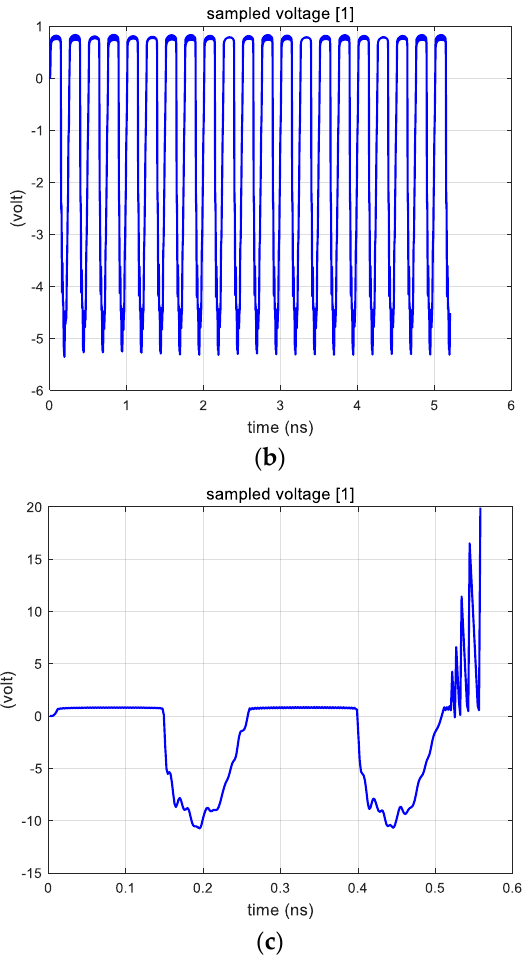
Figure 11. Sampled voltage across the diode using the traditional equivalent circuit method: ( a ) amplitude of 5 V; ( b ) amplitude of 10 V; ( c ) amplitude of 20 V.